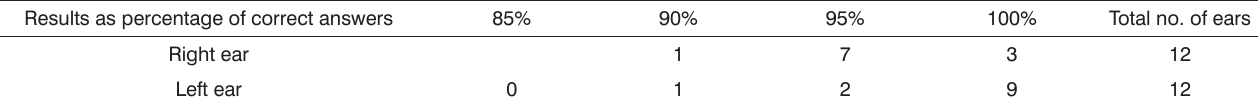
Table 2. Analysis of results of the frequency pattern test, per ear, for all participants (N=12). Results as percentage of correct